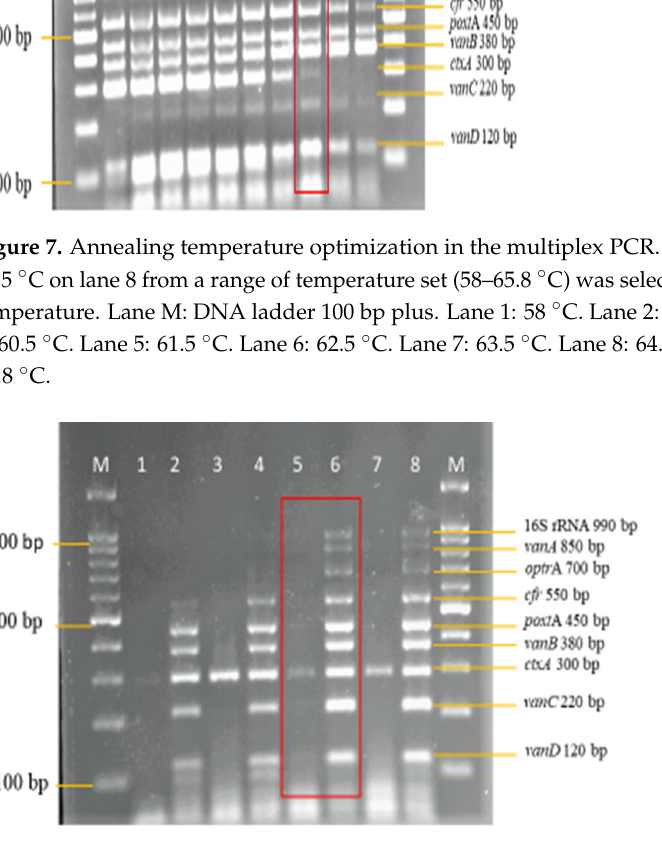
Table 5. Final optimized parameters of the nanoplex PCR assay for the detection of vancomycin- and linezolid-resistant genes in Enterococcus.